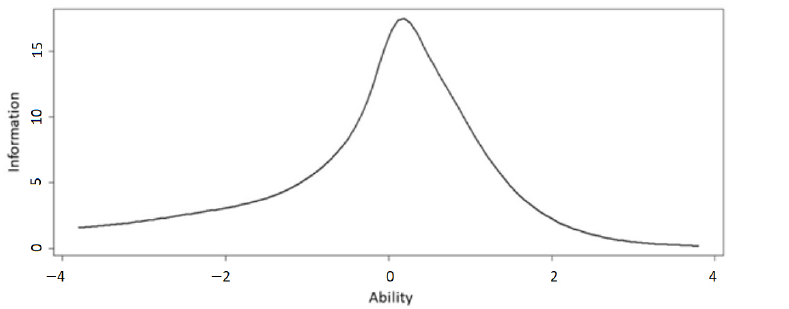
Figure 5. Test information function for the 25 Tower of London